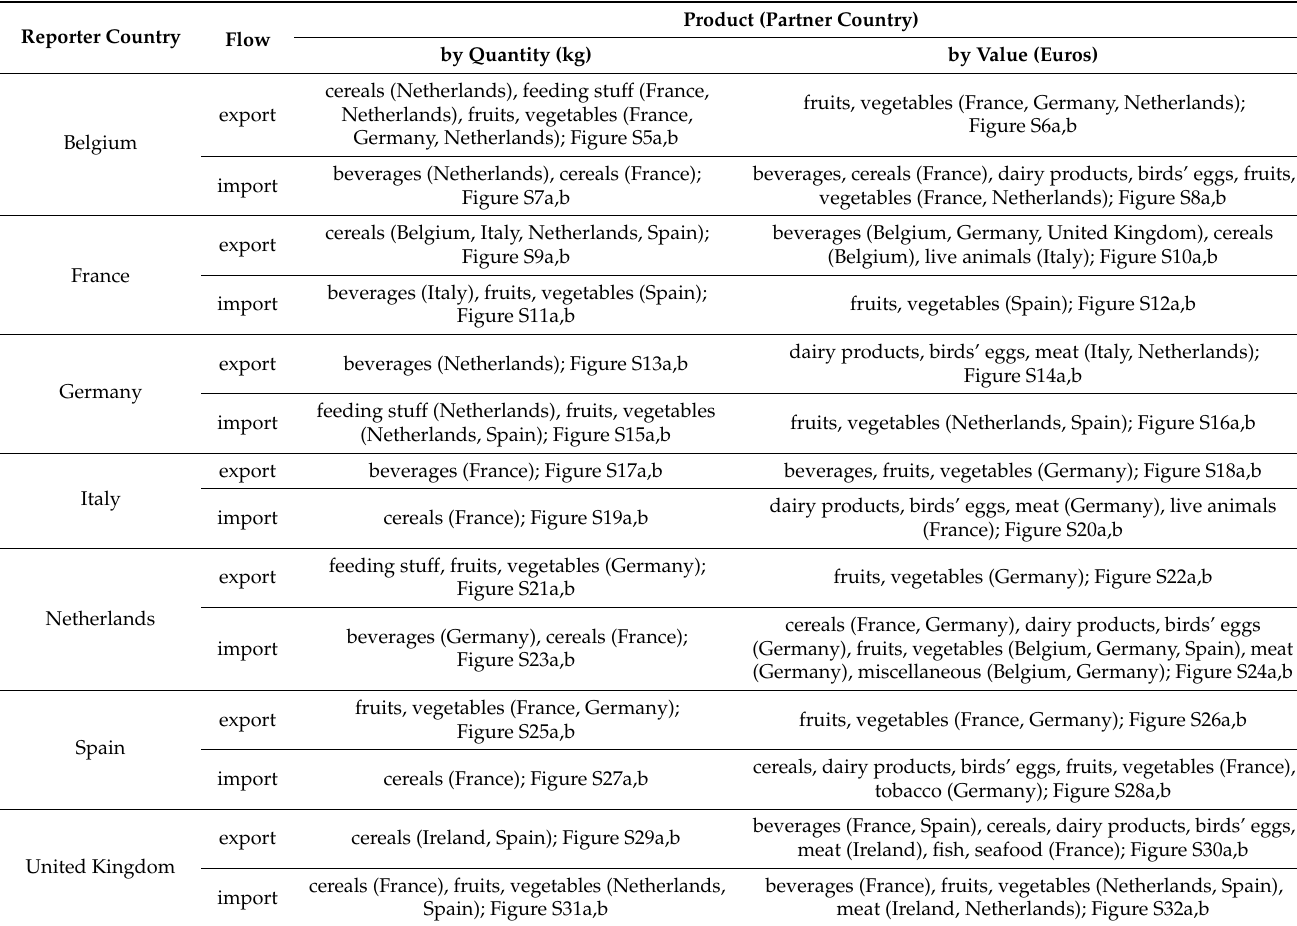
Table 4. Results of two-way joining cluster analysis within intra-EU food